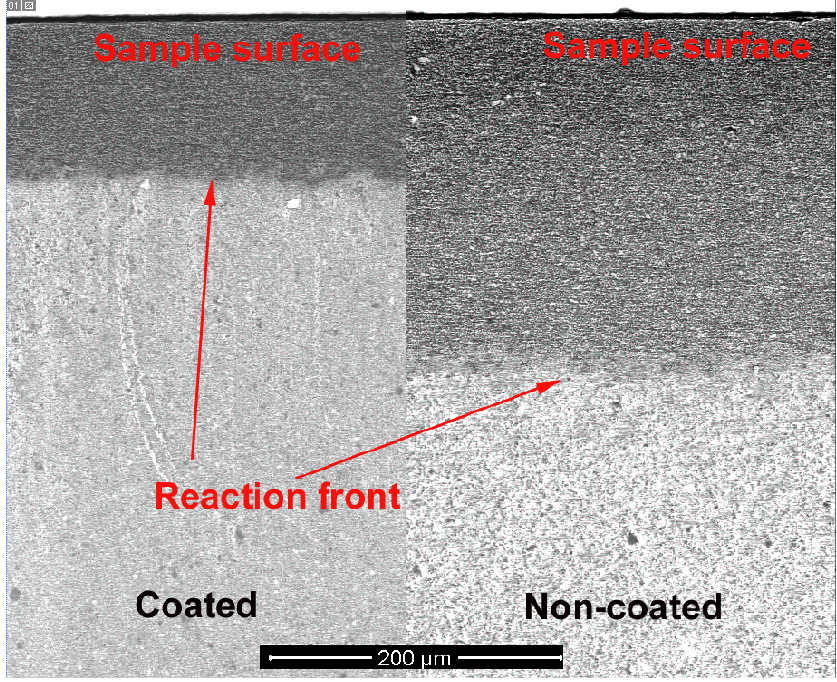
2.5- μ m Na- β ”-alumina surface coating substantially lowered the conversion kinetics.